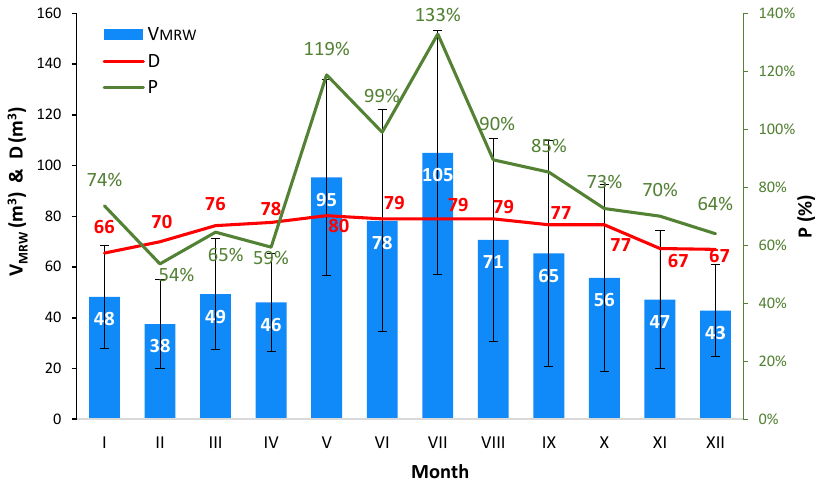
Figure 8. The amount of rainwater flowing from the roofs of the buildings in the Animal Breeding Centre in the RNP in different months of the year (V MRW ), demand for rainwater (D), and the potential to meet the Animal Breeding Centre’s needs (P) in the period 2001–2020.